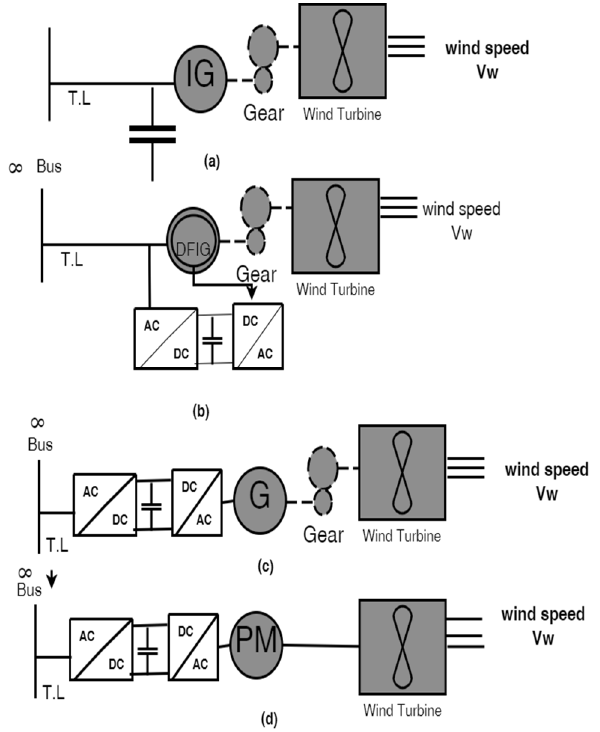
Figure 1. Wind turbine systems [2]: ( a ) Type1 ( b ) Type 2 ( c ) Type 3 ( d ) Type 4.